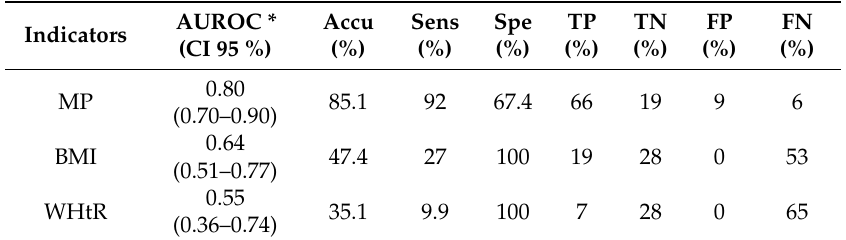
Table 4. Analysis of the performance in the test set of the proposed methods relative to the anthropometric indicators BMI and WHtR.